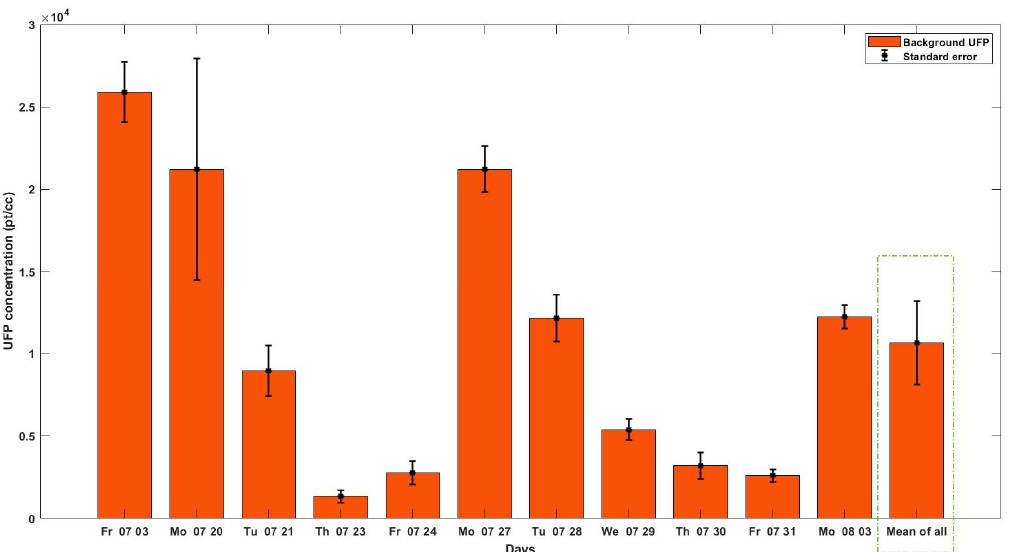
Figure 3. Bar plot of background UFP for each day of data collection (the error bars are the standard error of the means).